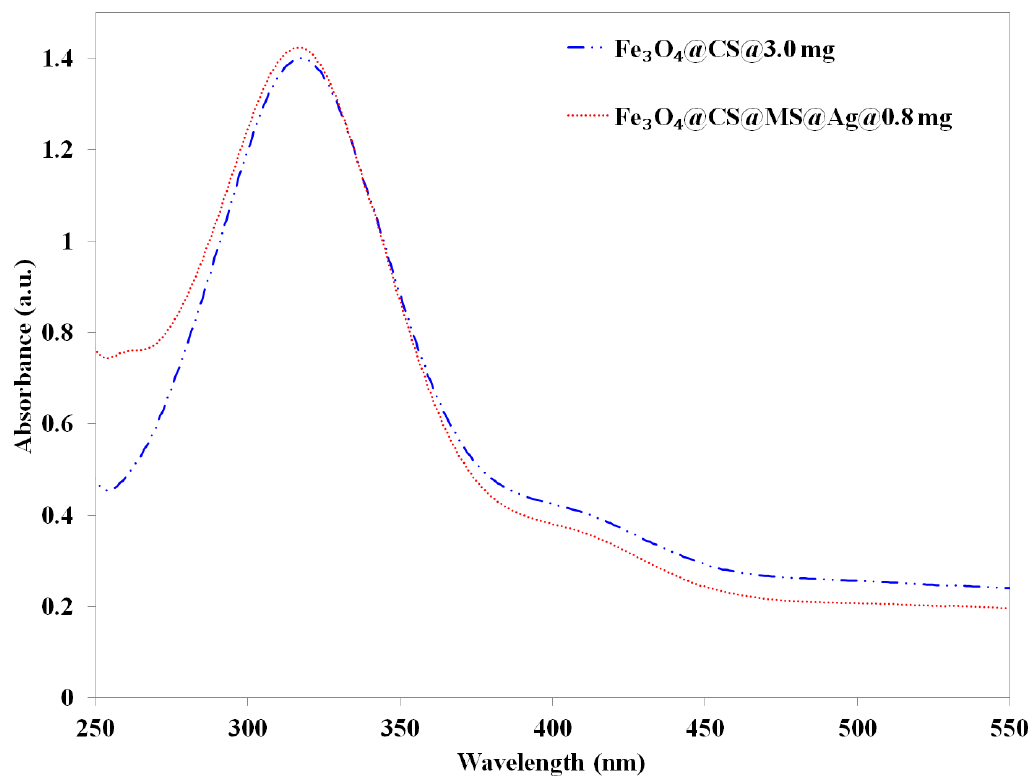
Figure 9. UV-Vis spectra for the reduction of 4-NP to 4-AP using 3.0 mg of Fe 3 O 4 @CS ( blue line) and 0.8 mg (6.5 × 10 −7 mol Ag) of Fe 3 O 4 @CS@MS@Ag ( -red line) after 10 min.